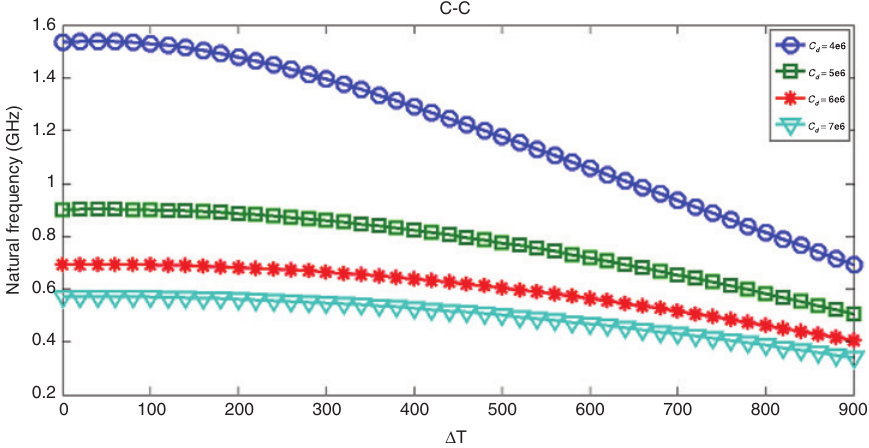
Figure 13: The effect of damping stiffness on natural frequency with clamped-clamped boundary condition.